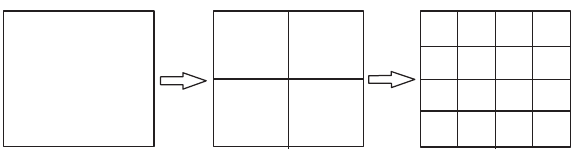
Figure 1: Sequence of grids on space mesh level: 1, 2, and 3 (from left to right).